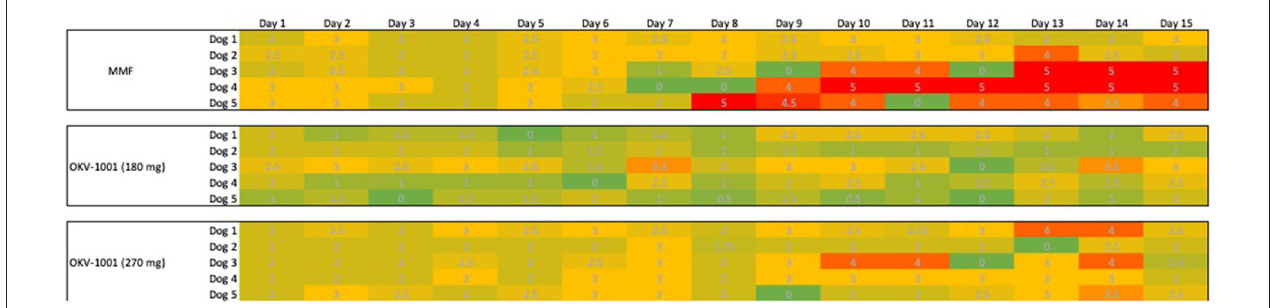
FIGURE 5 | Tabulated heatmap of modified Waltham fecal scores observed in dogs receiving MMF and OKV-1001b 270mg. Daily scores were coded from low (Green = 0), medium (3 = yellow) to high (5 = Red).